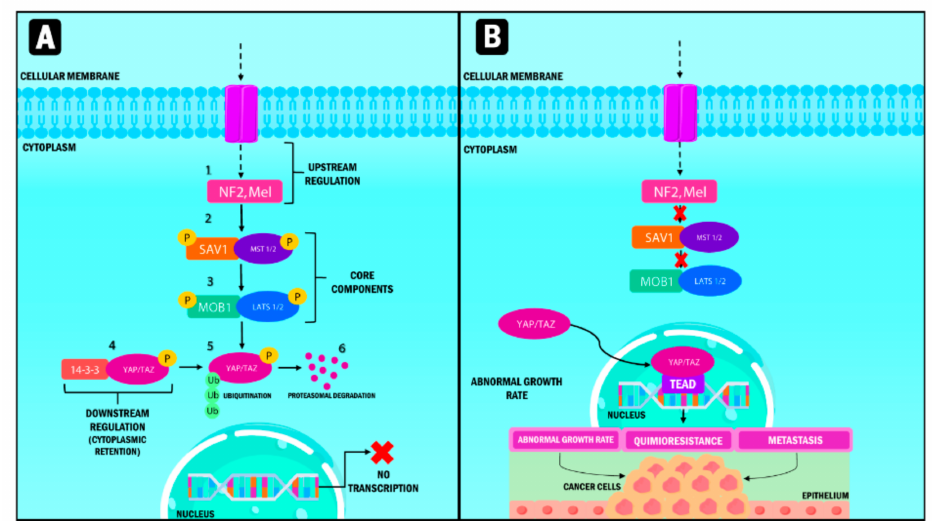
Figure 1. Representation of the Hippo signaling pathway in humans. When the Hippo pathway is ac- tive ( A ), multiple signals stimulate the upstream components, which are NF2 and Mel. Subsequently, MST 1/2 protein and its substrate, LATS 1/2, are activated through phosphorylation processes and phosphorylate YAP/TAZ, which interacts with the 14-3-3 protein. Phosphorylation causes their cytoplasmic retention and generates ubiquitination processes mediated by proteasome degradation. When the Hippo pathway ( B ) is inactive, YAP/TAZ that are not phosphorylated translocate into the nucleus and form a transcription factor complex by binding to TEAD. This pathway regulates the transcription of genes involved in abnormal multiplication, chemoresistance and metastasis. YAP: Yes-associated protein; TAZ: Transcriptional coactivator with PDZ-binding motif; NF2: Neurofibro- minin 2; MST: Mammalian sterile 20-like kinase; LATS: large tumor suppressor kinase; SAV1: Protein salvador homolog 1; MOB1: Mps1-binder-related; TEAD: Transcriptional enhanced associate